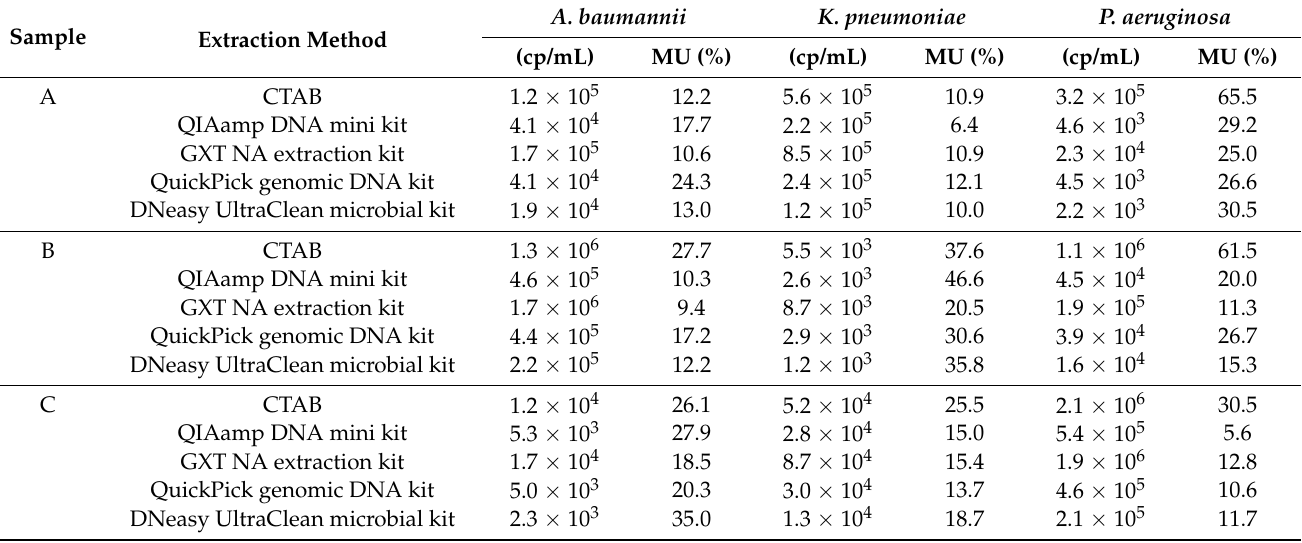
Table 2. Copy numbers and corresponding relative measurement uncertainties across the extraction systems for all three target bacteria.